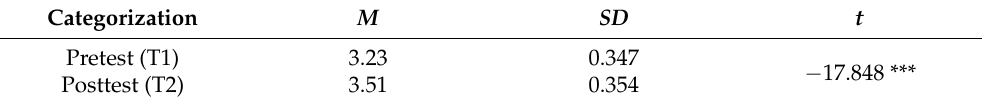
Table 2. Comparison of healthy lifestyle scores before and after participation in regular exercise. Categorization